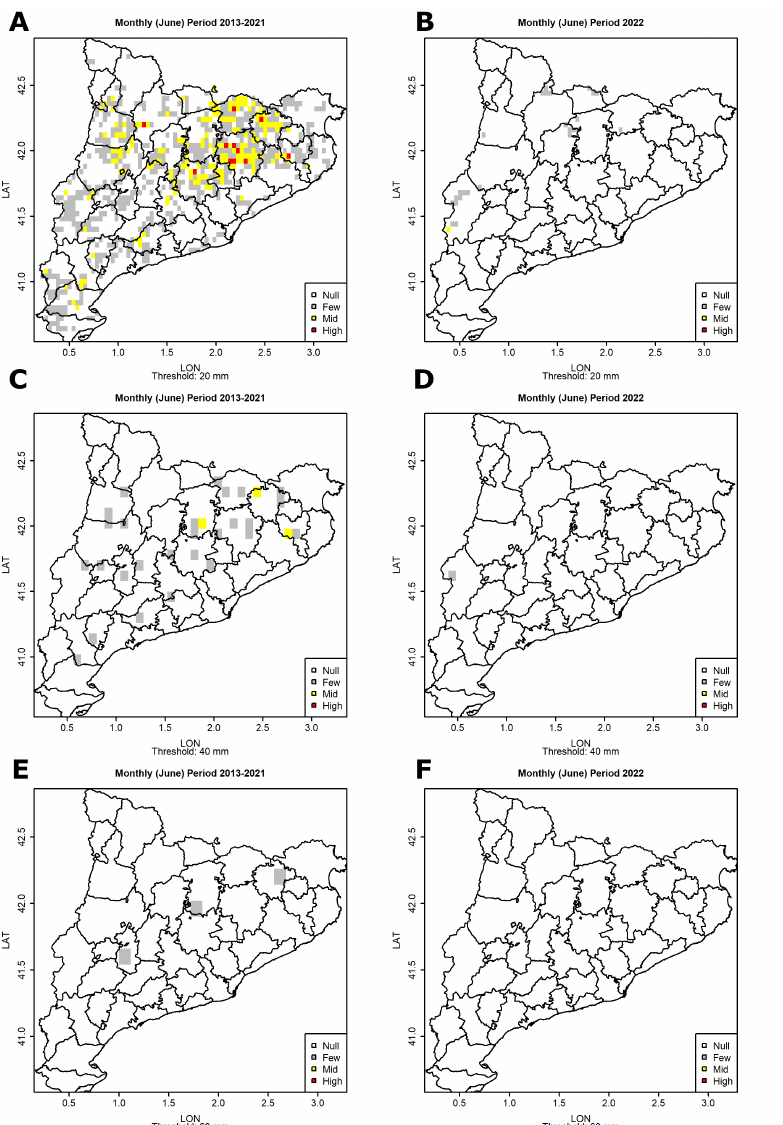
Figure 5. ( A – F ) Same as Figure 4, but for the June monthly